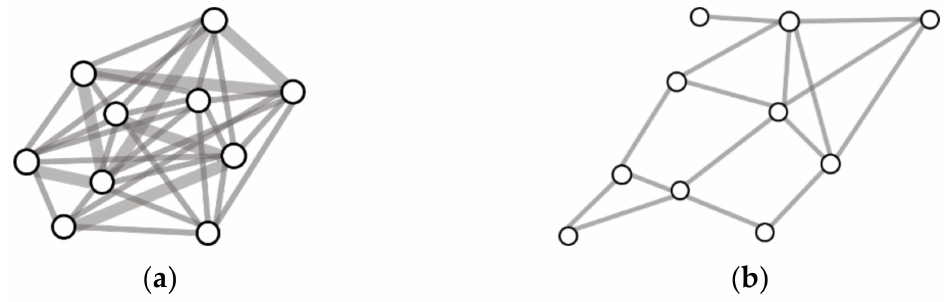
Figure 3. Concept of different shapes of networks: ( a ) aggregate shape and ( b ) dispersion shape.